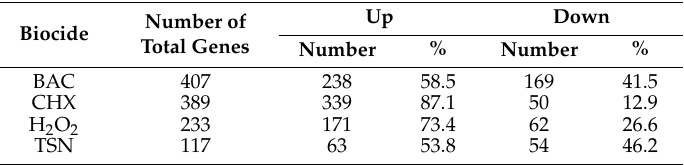
Table 2. Total number of genes with changed transcription (FDR < 0.10, for triclosan FDR < 0.13) for all comparisons. Numbers and percentages of genes with elevated and reduced transcripts in the presence of each biocide are presented. Abbreviations: BAC—benzalkonium chloride,